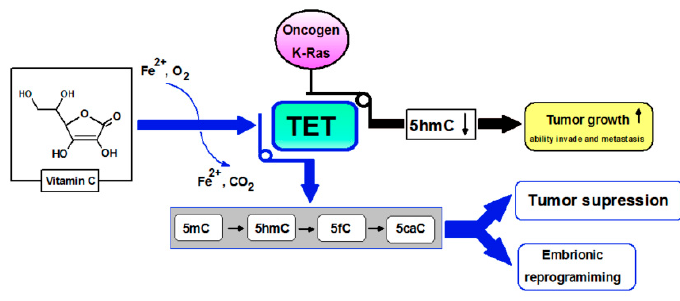
Figure 3. Vitamin C ensuring the proper functioning of TET proteins according to [24,27–29]. K-Ras, oncogene product of KRAS gene; TET, methylcytosine oxidase ten-eleven translocation proteins; 5-mC, 5-methylcytosine; 5-hmC, 5-hydroxymethylcytosine; 5-fC, 5-formylocytosine; 5-caC, 5-carboxycytosine.